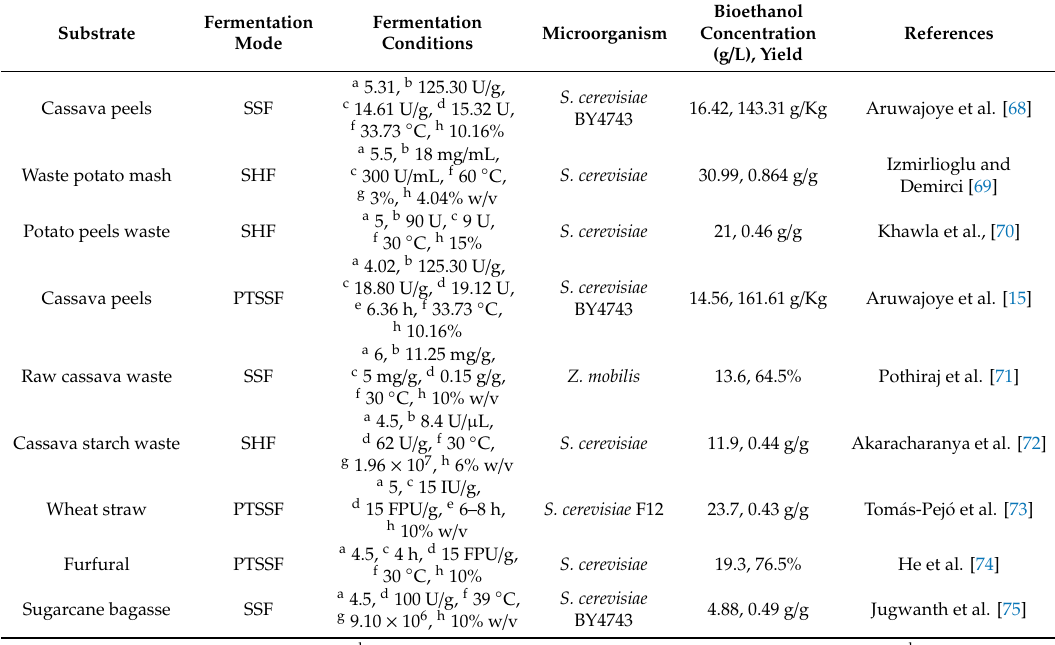
Table 3. Bioethanol production from agro-based lignocellulosic